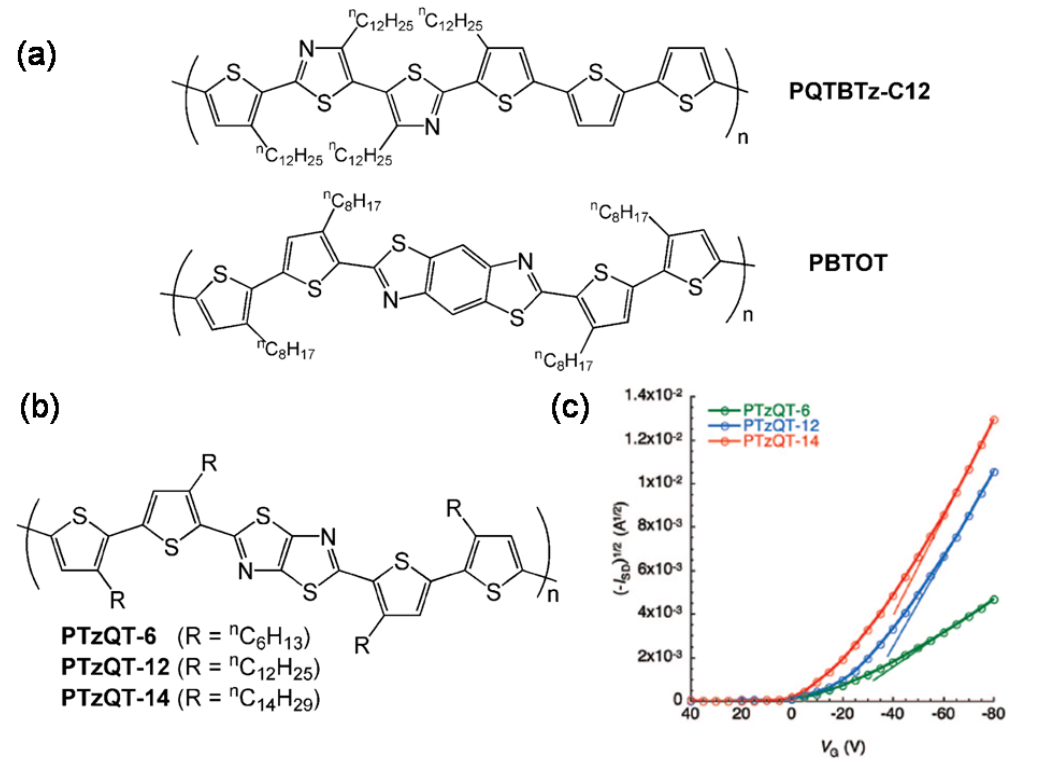
Figure 16. (a) Chemical structure of copolymers PQTBTz-C12 and PBTOT ; (b) Chemical structure of copolymers PTzQT-R ; (c) Evolution of the transfer characteristics of the annealed polymers (150 °C) with alkyl chain length. Reproduced with permission from reference [76]. Copyright 2009 American Chemical